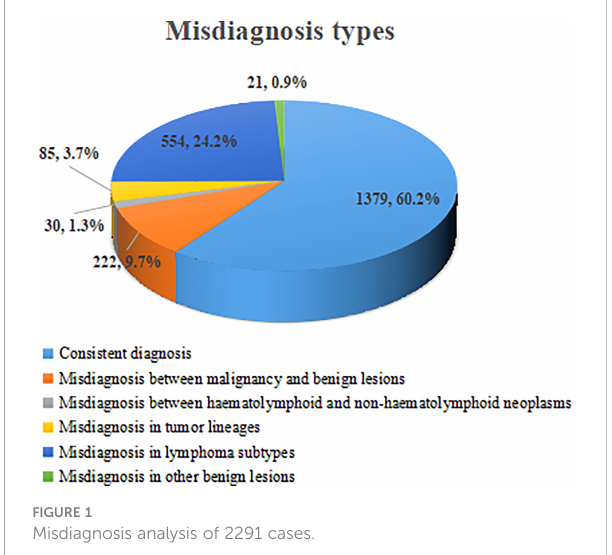
FIGURE 1 Misdiagnosis analysis of 2291